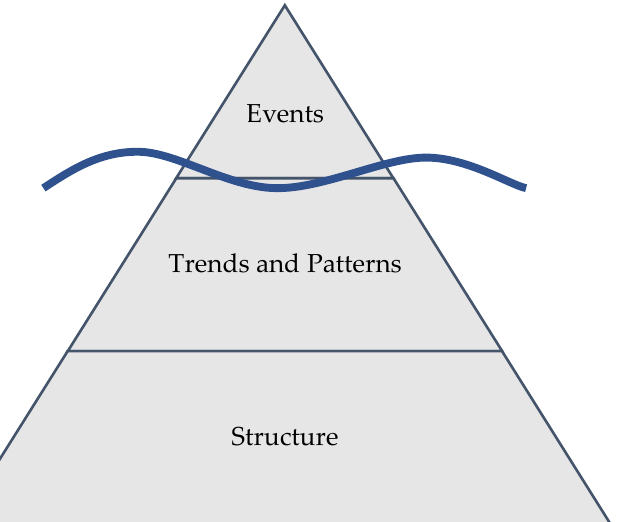
Figure 1. Iceberg Diagram depicting structure as the level giving rise to trends, patterns, and events.